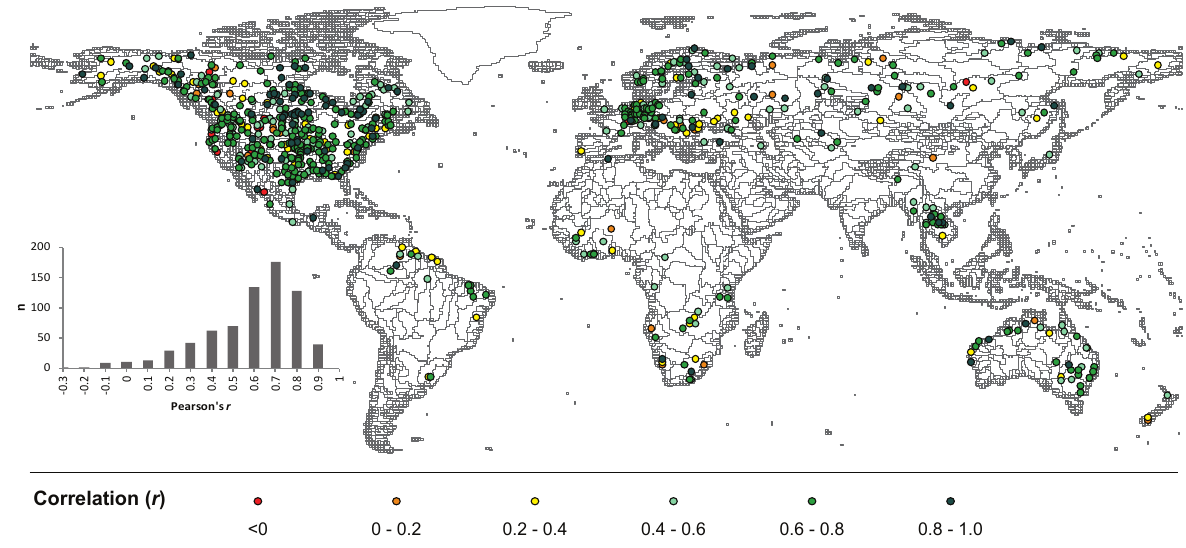
Fig. 2. Correlation ( r) between modelled and observed ln Q max time series over the period 1959–2000. Inset shows histogram of values for individual locations. The median value of r is 0.64, and the 25th and 75th percentiles are 0.48 and 0.75,